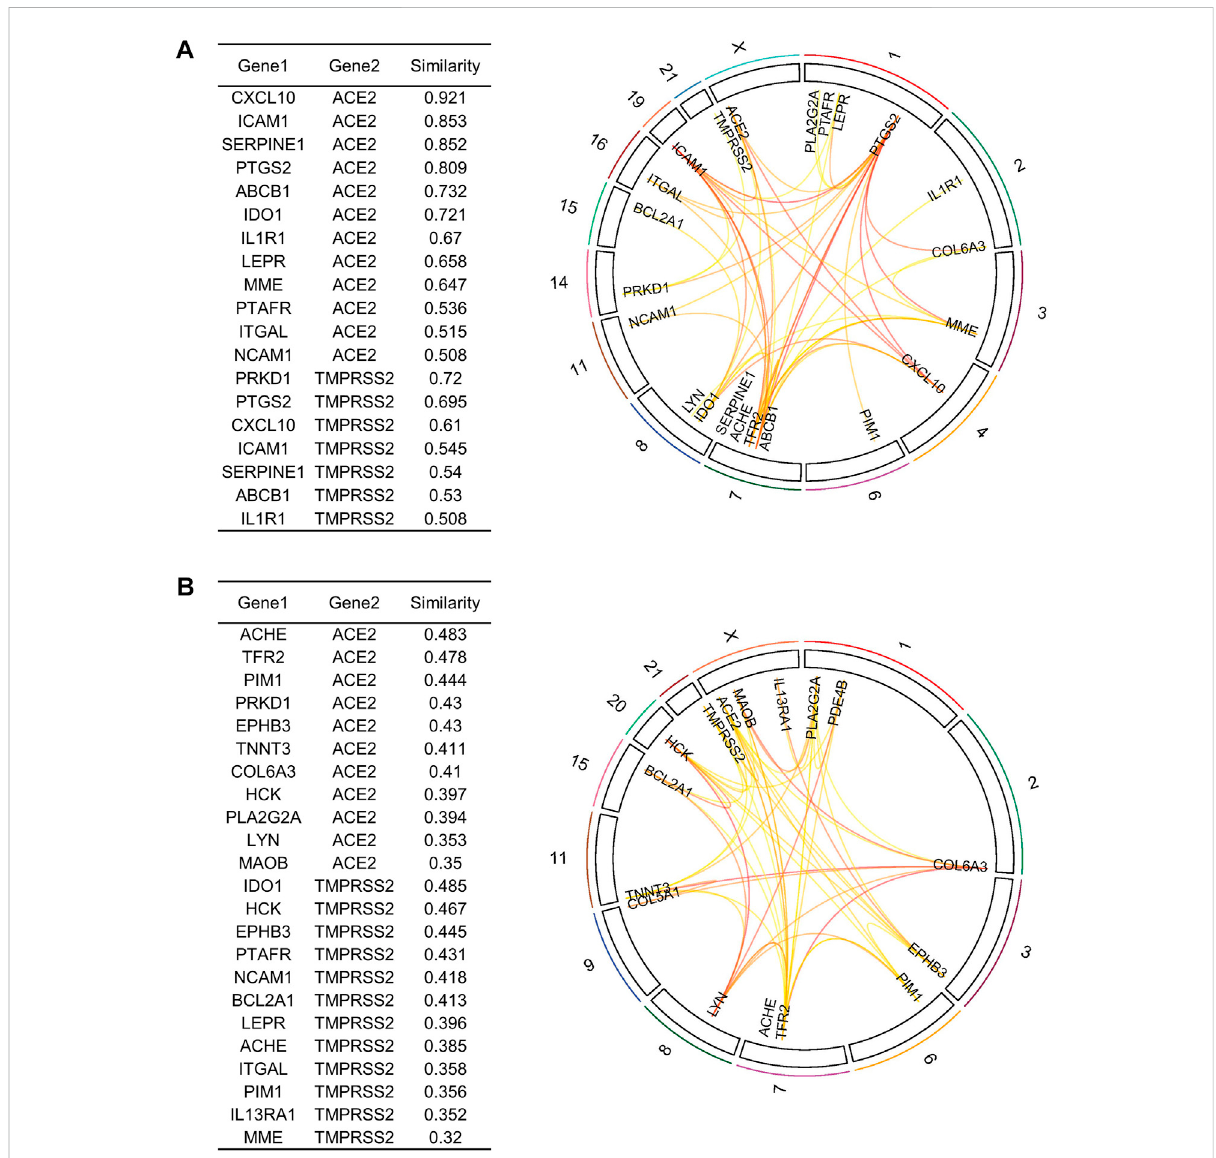
FIGURE 8 Similarity analysis and degree of relatedness of drug target genes to ACE2 and TMPRSS2 as a group to each other using eXploring Genomic Relations for enhanced interpretation. (A) ACE2 and TMPRSS2 showed a high degree of similarity with 13 out of the 29 identi fi ed genes. (B) Similarity analysis of the remaining 16 drug target genes. Drug targets were fi ltered based on cutoff score ≥ 0.5 as highly similar and ≤ 0.5 as slightly similar to ACE2 and